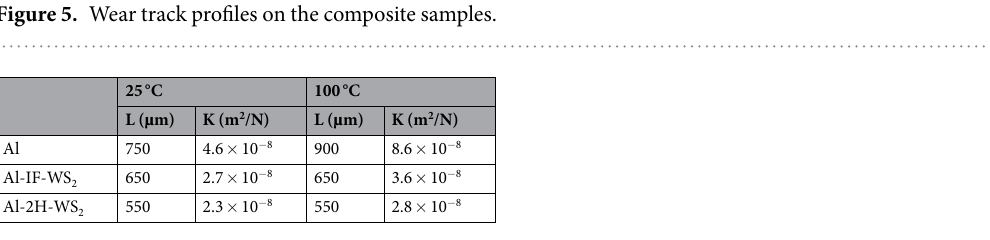
Table 3. Wear track width and wear coefficient for the three